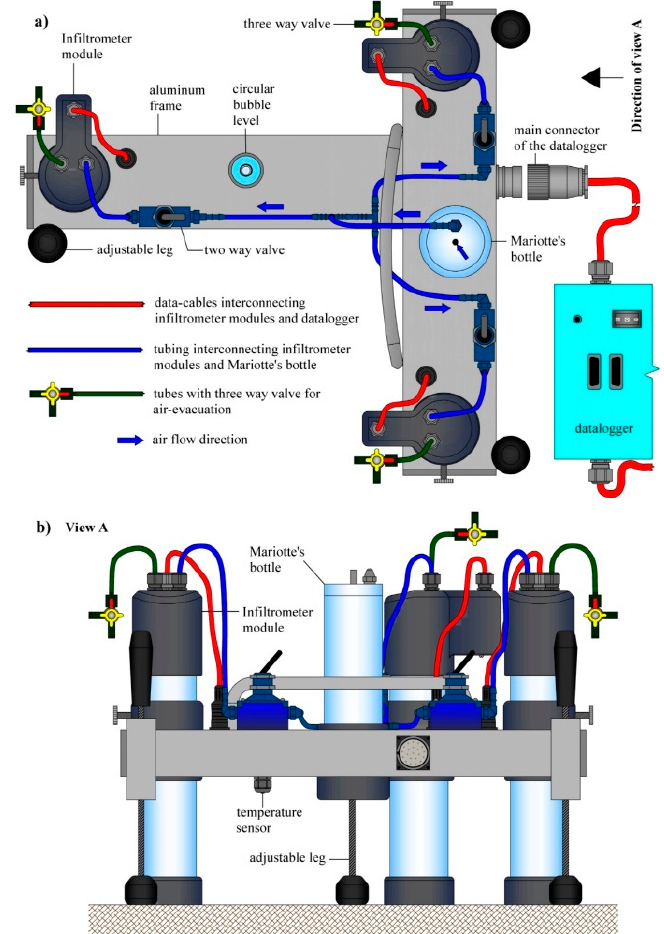
Figure 2. Scheme of one triplet of the MultiDisk infiltrometer modules held by an aluminum frame viewed, ( a ) from the top and ( b ) from the side (View A). Note that one apparatus-MultiDisk-consists of two identical triplets.